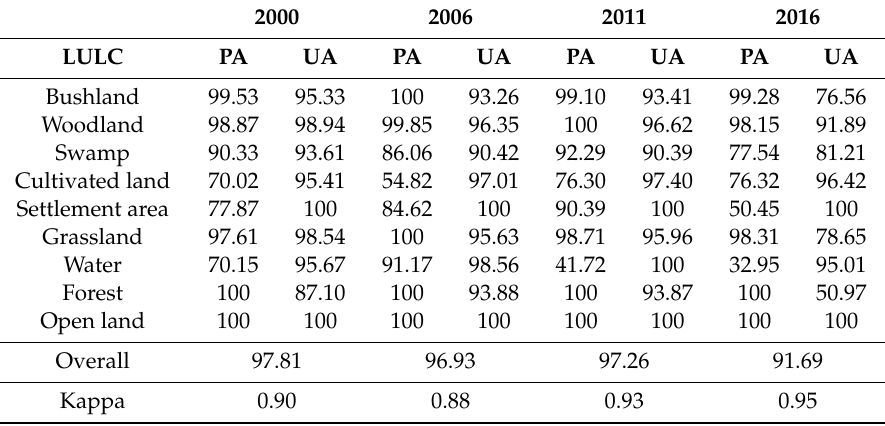
Table 3. Accuracy assessment of the LULC classification at Kinyasungwe